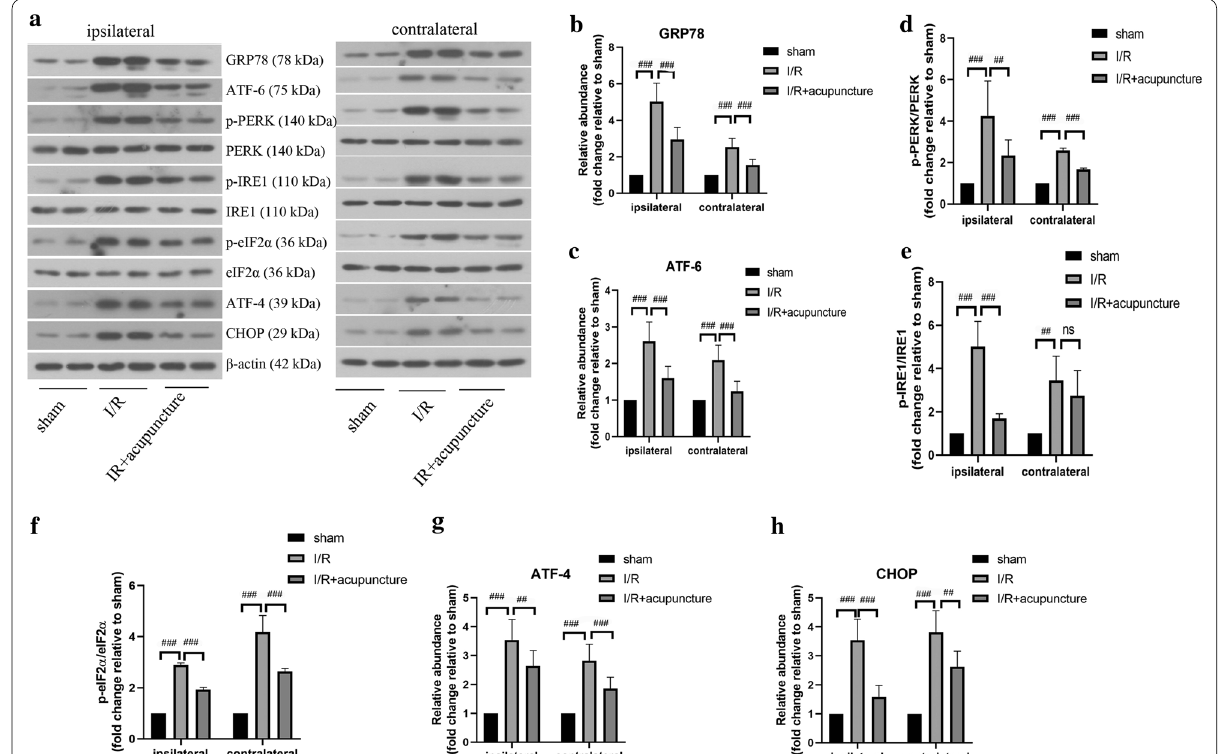
Fig. 3 Effect of acupuncture on cerebral ischemia–reperfusion (I/R) injury-induced endoplasmic reticulum (ER) stress. Experiments were performed at 72 h after the reperfusion in the ipsilateral and contralateral brain tissues. a The protein levels of glucose-regulated protein 78 (GRP78), transcription factor 6 (ATF-6), PKR-like ER kinase (PERK), phosphorylated PERK (p-PERK), inositol-requiring protein 1 (IRE1), phosphorylated IRE1 (p-IRE1), α unit of eukaryotic initiation factor 2 (eIF2α), phosphorylated eIF2α (p-eIF2α), transcription factor 4 (ATF-4), and C/EBP-homologous protein (CHOP) in brain tissues were detected by western blotting assay. β-actin was used as an internal control. b – h The relative abundance of the protein bands was calculated and shown. Results represent at least three independent experiments. Each experimental result was presented as mean standard deviation (n 6). ## P < 0.01, ### P < 0.001 versus the indicated ± =